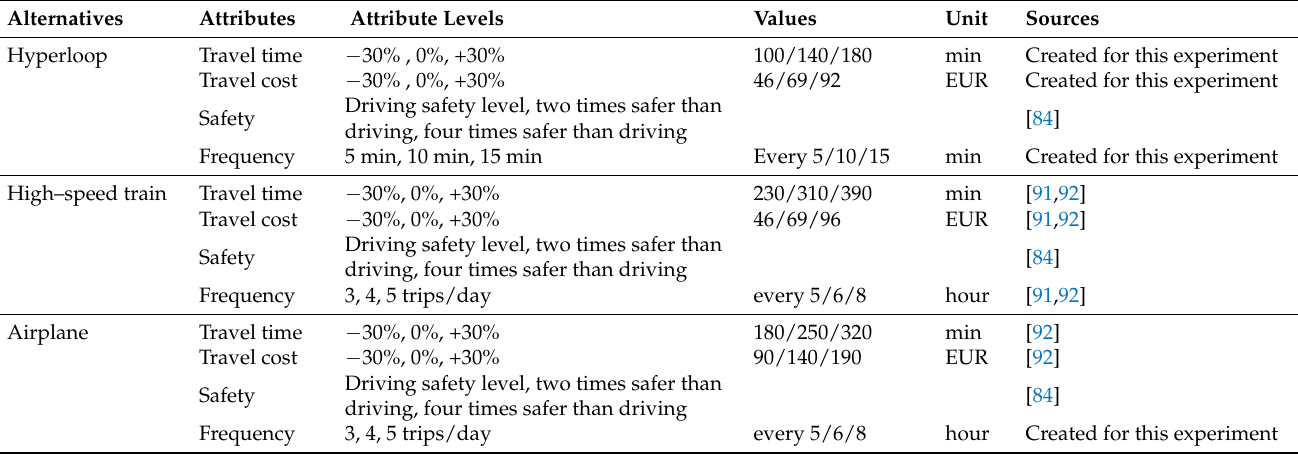
Table 2. Scenario levels and attributes.